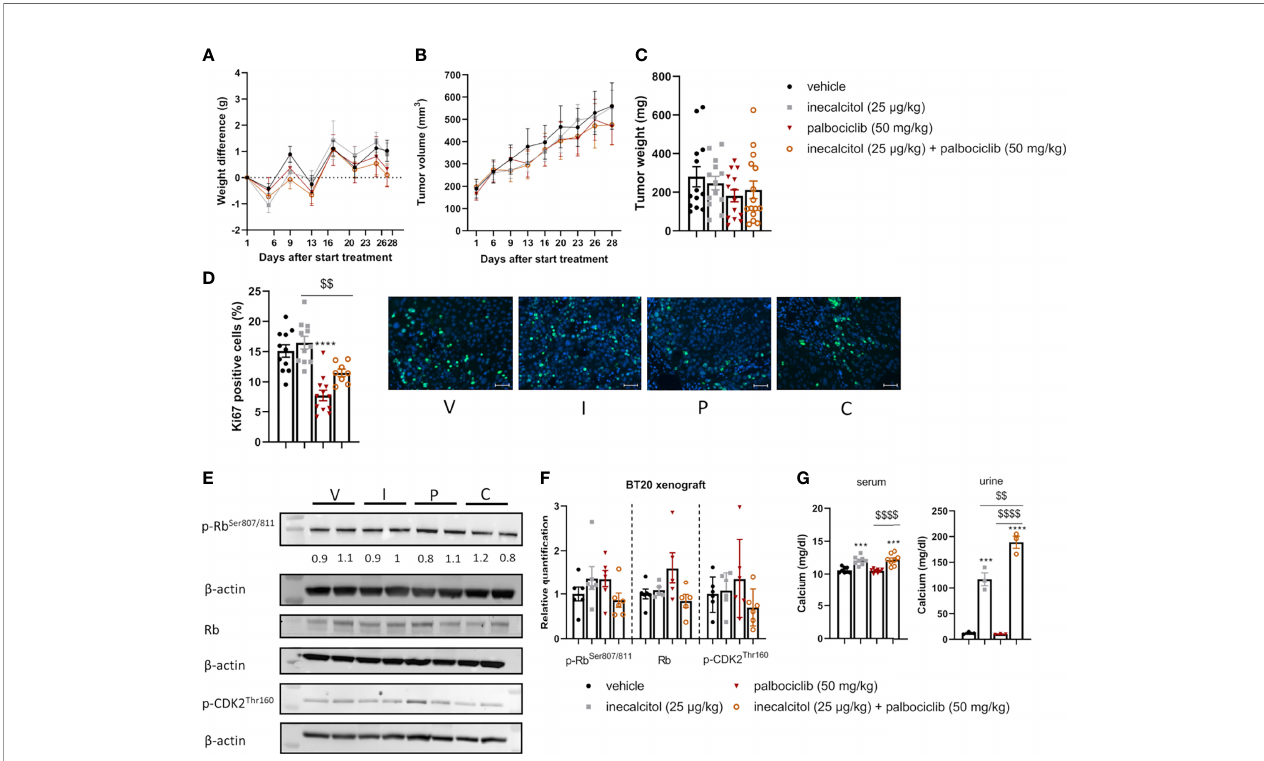
FIGURE 7 | Analysis of the in vivo effect of inecalcitol and palbociclib treatment in a TNBC BT20 xenograft model. (A) Weight difference compared to start weight during treatment (Mixed effect analysis followed by one-way ANOVA, Sidak ’ s multiple comparison test). (B) Tumor volume during treatment (8 mice/group) (Mixed effect analysis followed by one-way ANOVA, Sidak ’ s multiple comparison test). (C) Tumor weight at day 28 of treatment (13-15 tumors/group). (D) Immunohistochemistry analysis of Ki67 staining on tumor samples (8-12 tumors/group) and representative pictures of Ki67 staining (green) with DAPI counter staining (blue) per group: vehicle (V), inecalcitol (25 µg/kg) (I), palbociclib (50 mg/kg) (P) and combination (C). Scale bar = 50 µm. (E) P-Rb, total Rb (110 kDa) and p-CDK2 (33 kDa) protein expression in tumors from vehicle (V), inecalcitol (25 µg/kg) (I), palbociclib (50 mg/kg) (P) and combination (C) treated mice (6 tumors/group). One representative blot is shown. b -actin (42 kDa) was used as loading control. The ratio of phosphorylated to non-phosphorylated relative protein expression is indicated under the representative blot. Data are expressed as fold increase vs control (control value = 1). (F) Relative quanti fi cation of p-Rb, total Rb and p-CDK2 protein expression (5/6 tumors/group). Data shown as mean ± SD. (G) Serum (8 mice/group) and urine (3 pooled samples/group) calcium concentration. Data shown as mean ± SEM of one experiment (8 mice/group) ***p ≤ 0.001; ****p ≤ 0.0001 compared to vehicle; $$ p ≤ 0.01; $$$$ p ≤ 0.0001 compared to inecalcitol or palbociclib monotherapy (one-way ANOVA, Sidak ’ s multiple comparison